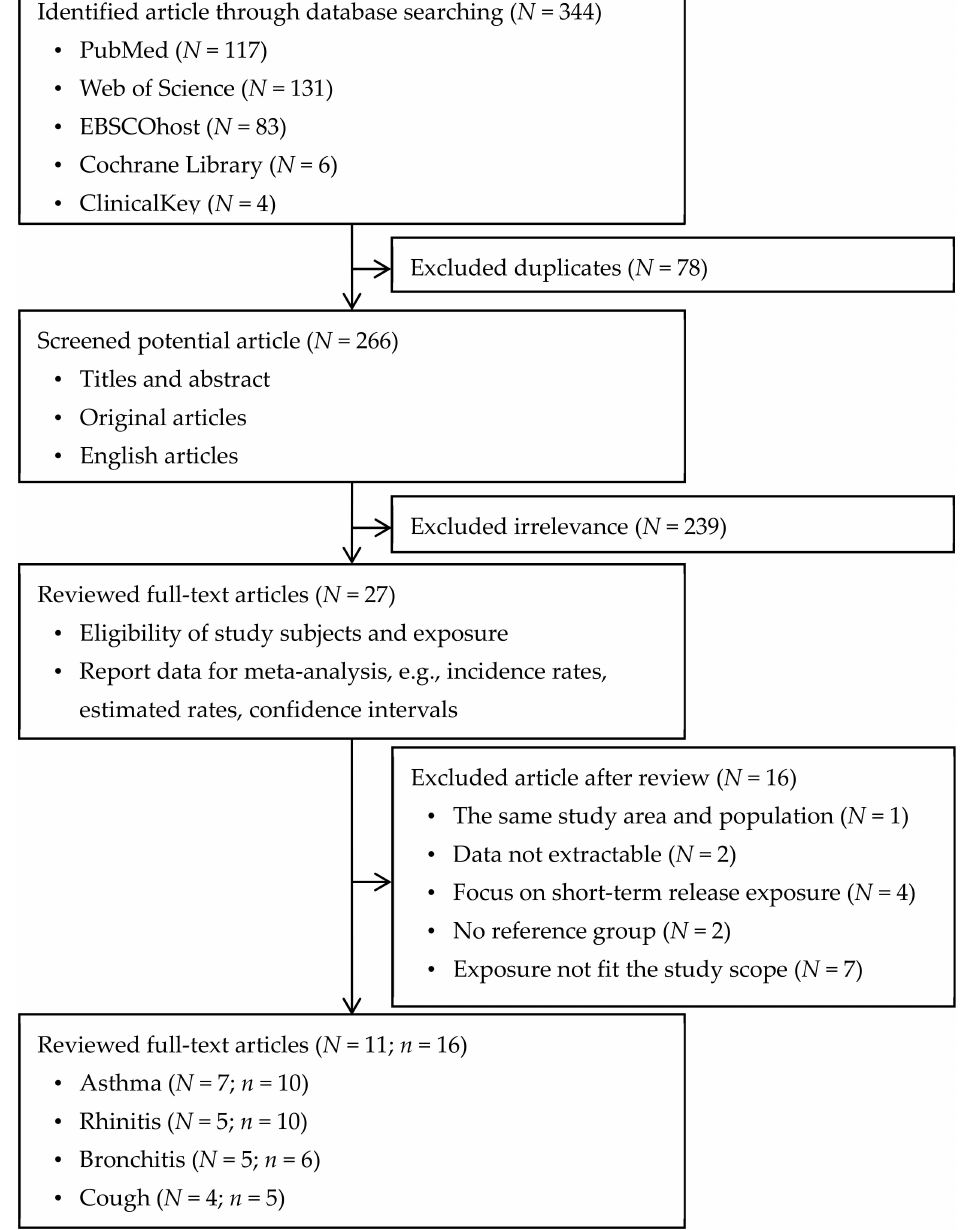
Figure 1. Search process for reports on respiratory symptoms among residents living near petrochemical industrial complexes. Abbreviations: N , number of articles; n , number of study groups included in the